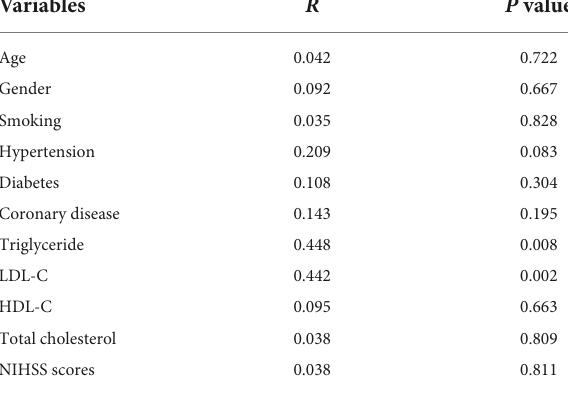
TABLE 2 Correlation between serum 4-hydroxynonenal (4-HNE) and other variables using spearman correlation coefficient in primary cerebral infarction